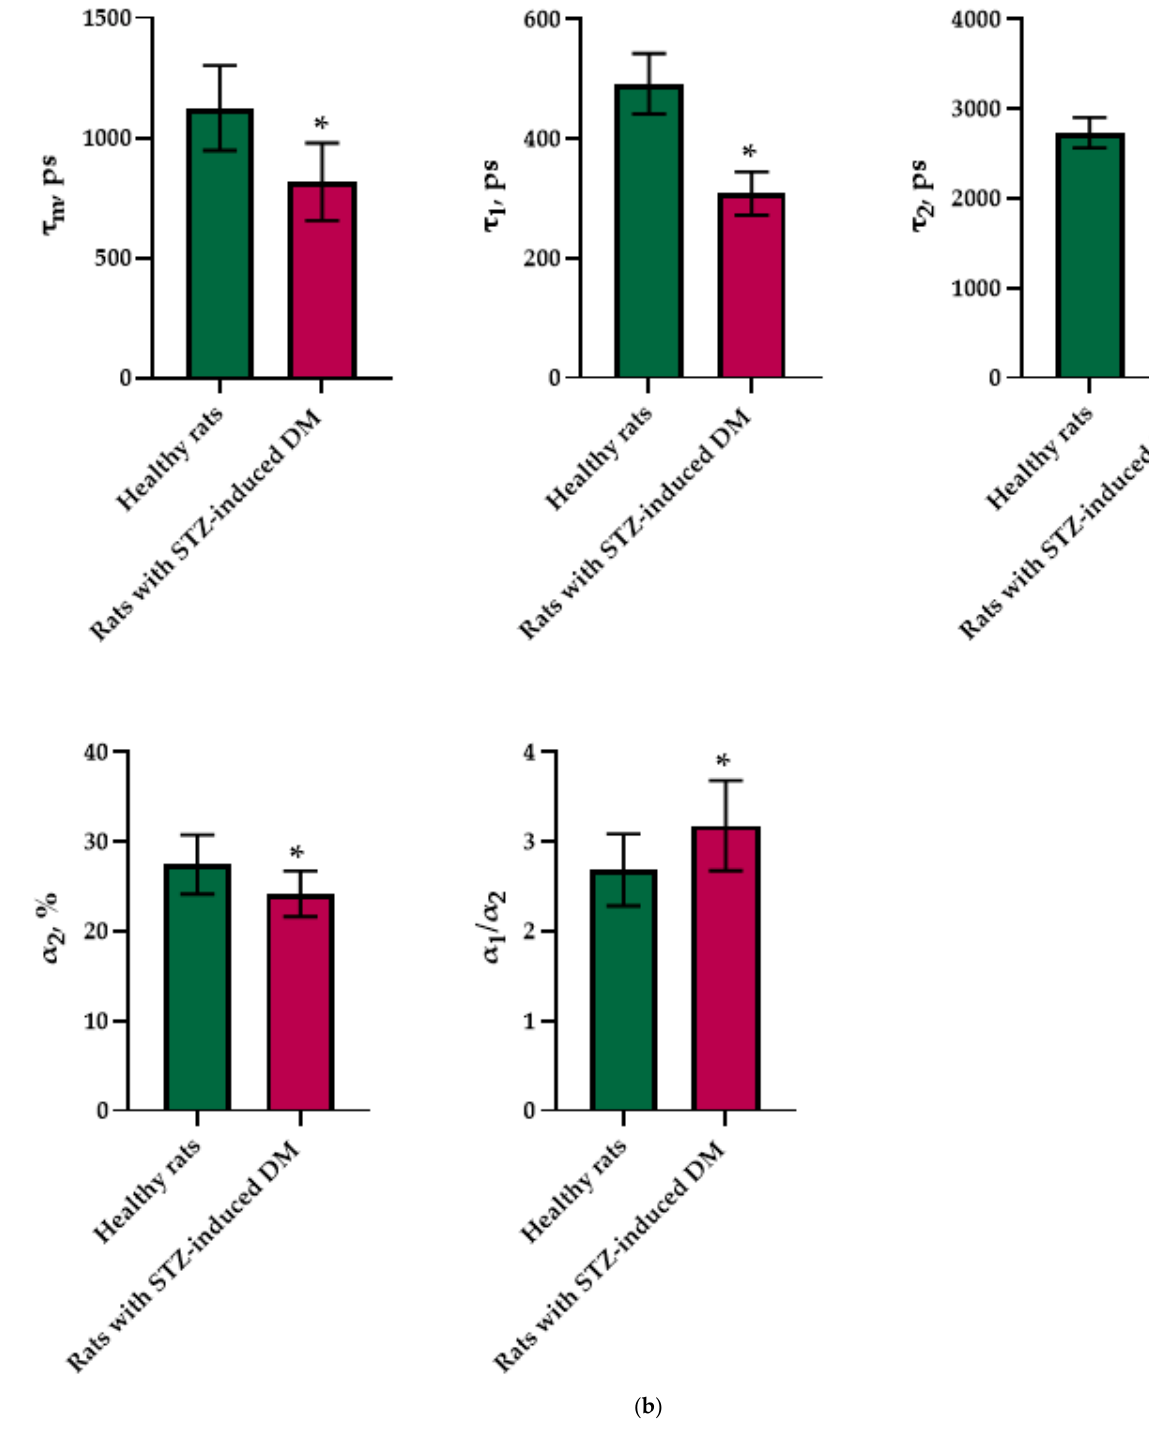
Figure 1. FLIM of NAD(P)H in pancreatic islets of healthy rats and rats with STZ-induced DM. ( a ) Pseudo-color-coded images of τ m, τ 1, τ 2, α 2 and α 1/ α 2 of the NAD(P)H in pancreatic islets of healthy rats and rats with STZ-induced DM (scale bars: 600–1100 ps ( τ m), 200–500 ps ( τ 1), 1500– 3000 ps ( τ 2), 10–25% ( α 2) and 1–5 ( α 1/ α 2)). The scale length in all pictures is 100 µm. ( b ) Mean values of τ m, τ 1, τ 2, α 2 and α 1/ α 2 of the NAD(P)H in pancreatic islets of healthy rats and rats with STZ-induced DM (mean ± SD). *— p = 0.00000 ( τ m, τ 1, τ 2) and p = 0.001 ( α 2, α 1/ α 2). Histological staining of pancreatic samples with hematoxylin and eosin showed a decrease in the size of the islets of diabetic rats compared to healthy animals (Figure 2). It was also found that the nuclei of the islets of animals with STZ-induced DM were larger